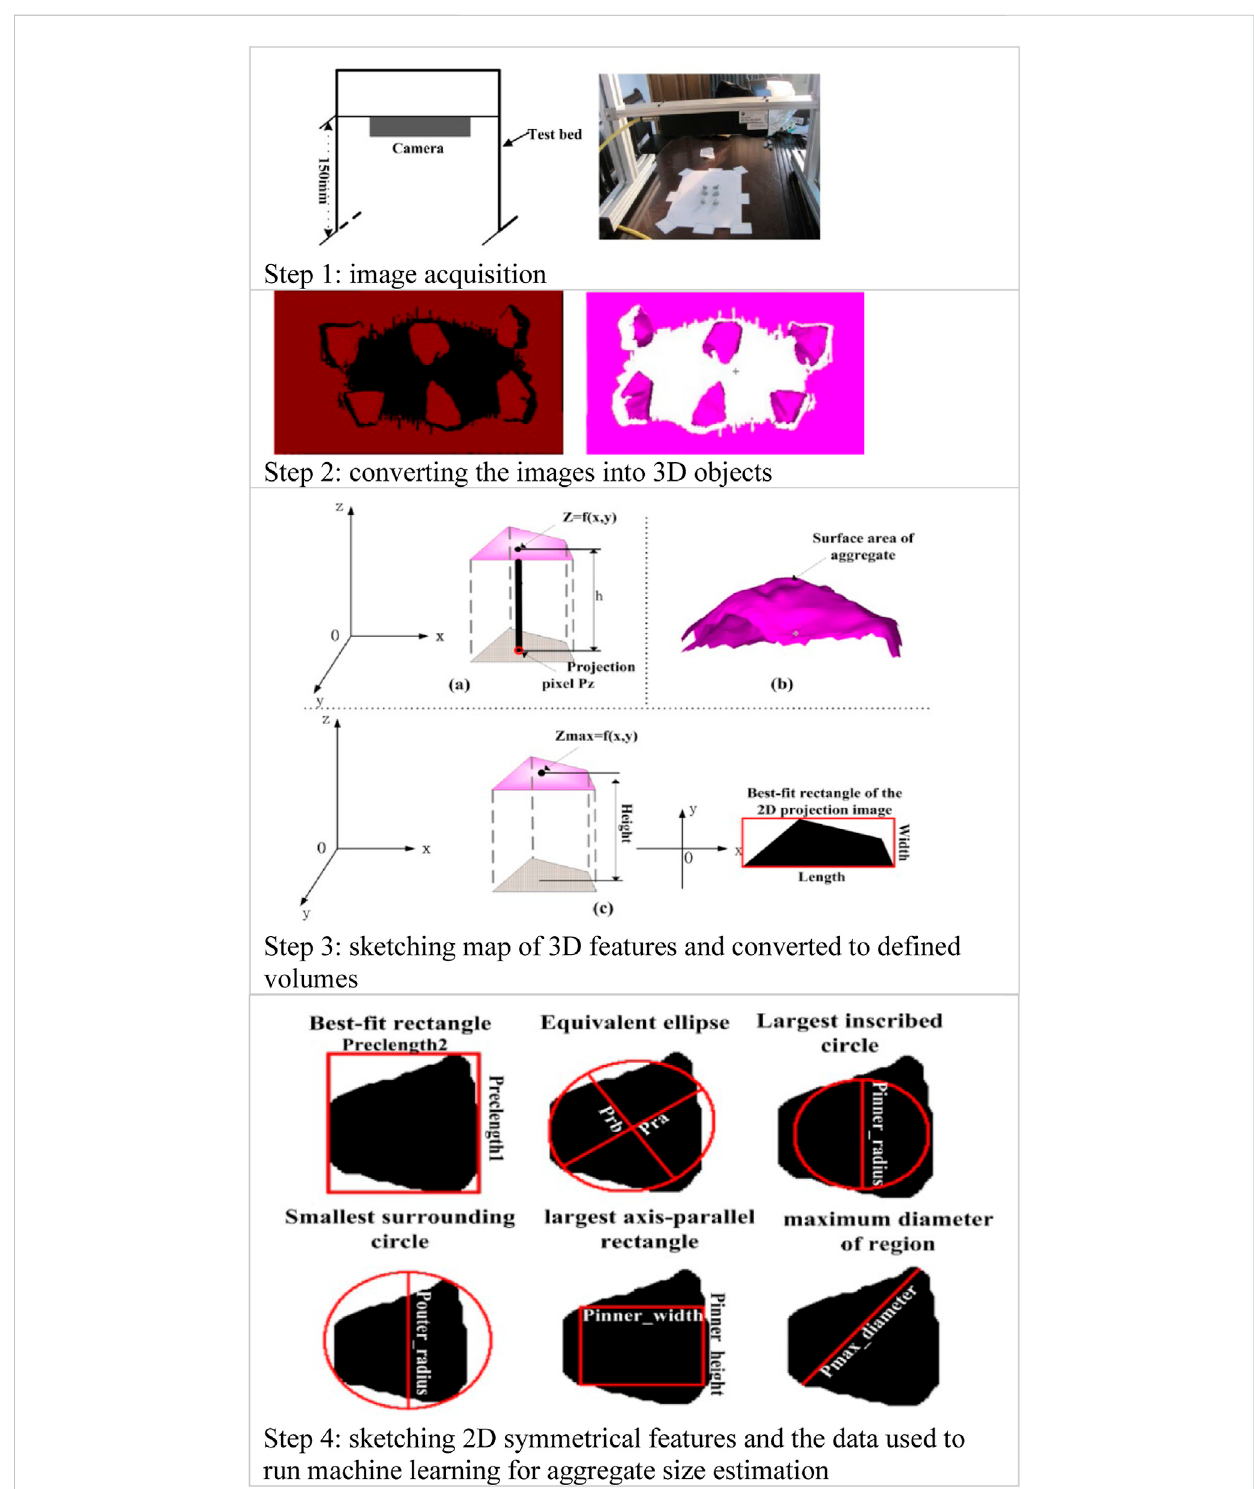
FIGURE 4 Importance-based machine learning feature to de fi ne the aggregate size distribution using measured 3D binocular system, rearranged after (Sun et al., 2021). Step 1: Image acquisition. Step 2: Converting the images into 3D objects. Step 3: Sketching map of 3D features and converted to de fi ned volumes. Step 4: Sketching 2D symmetrical features and the data used to run machine learning for aggregate size